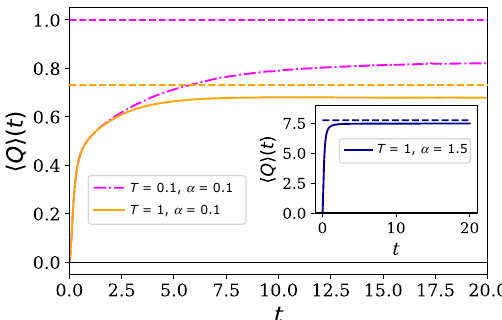
FIG. 5. Mean heat (cid:3) Q (cid:4) ( t ) exchanged by the bath for the spin- boson model in weak coupling at temperatures T = 1 (solid line) and T = 0.1 (dash-dot line), as a function of time, for an ini- tial state of the system set to | ↑(cid:4) . Dashed lines represent the sum of the energy change in the system and the reorganization energy of the bath for the corresponding temperatures and cou- pling strengths. Inset: same plot for temperature T = 1 and strong coupling. The parameters controlling the numerical accuracy are K (cid:6) = 5, (cid:6) = 0.01, and p = 100, and the derivative is taken at u = 0.01. For all the plots, ω C = 5.